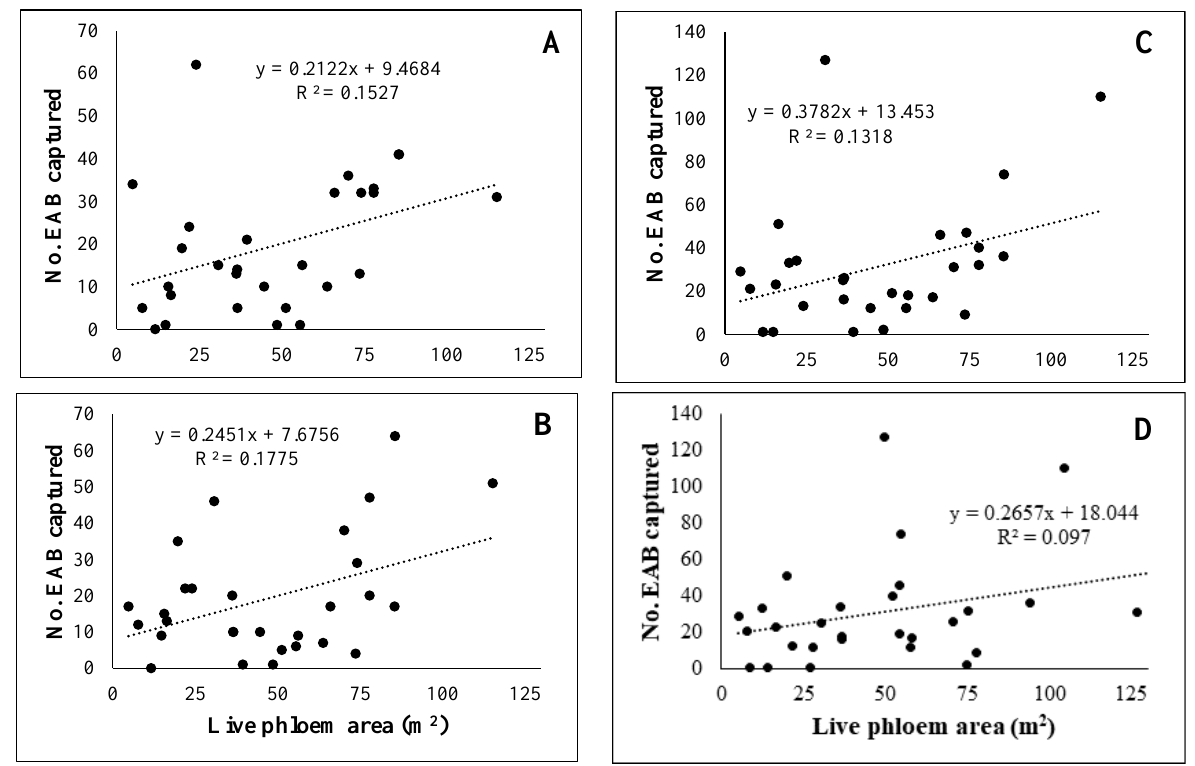
Figure 3. Linear relationship between emerald ash borer (EAB) adult captures in ( A ) 2014, ( B ) 2015, and ( C ) 2016 and adjusted area of live white ash phloem (m 2 ) surrounding traps (18 m radius) measured in 2014 and between EAB adult captures in 2016 ( D ) and adjusted area of live white ash phloem (m 2 ) measured in 2016. Phloem area (m 2 ) of tallied trees was estimated following methods of McCullough and Siegert [18]; then, it was reduced by the proportion of the canopy that was dead.